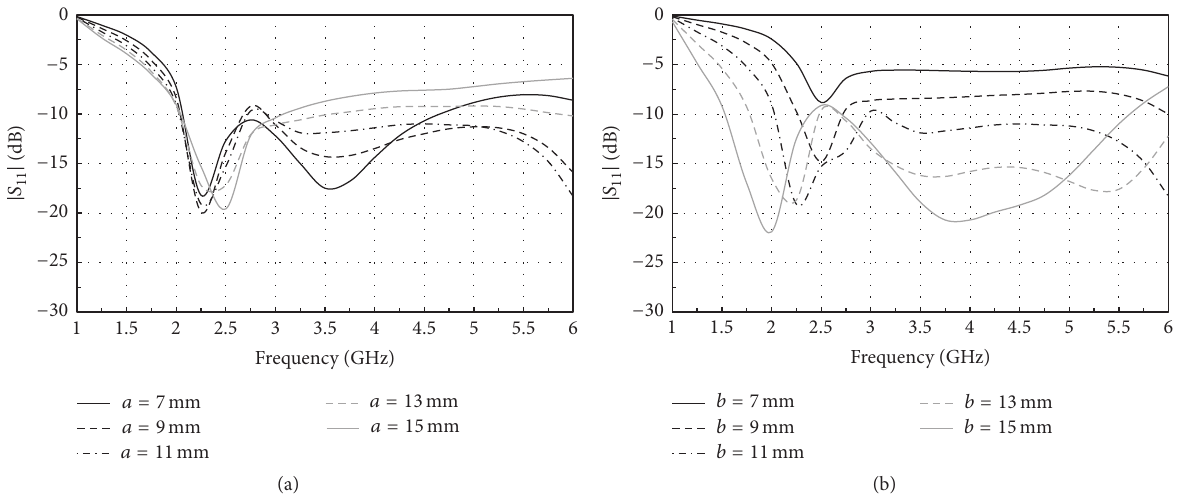
Figure 6: (a) Characteristics of |𝑆 11 | by varying 𝑎 . (b) Characteristics of |𝑆 11 | by varying 𝑏 .